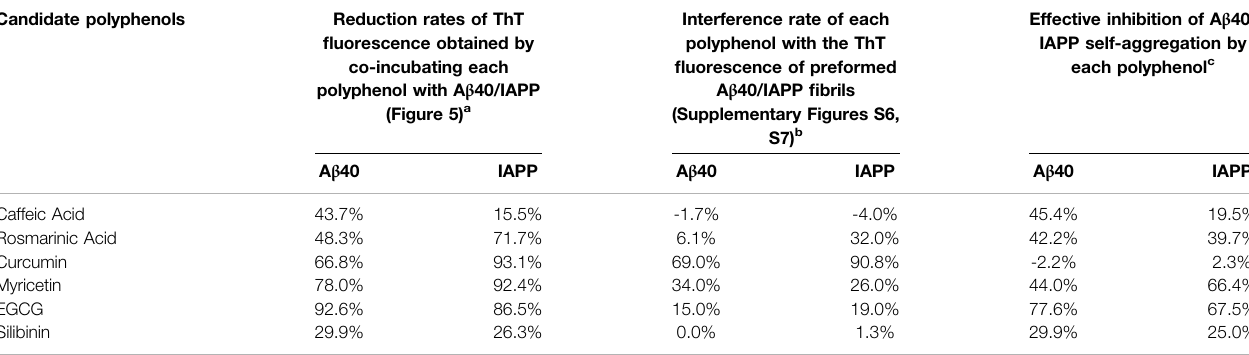
a Reduction rates of ThT fl uorescencewere obtained from Figure 5 by calculating the reductions ofthe normalizedThT fl uorescenceof A β 40 or IAPP in the presence of each polyphenol relative to the control (A β 40 alone/IAPP alone) × 100. b InterferenceratesofThT fl uorescencewereobtainedfrom SupplementaryFiguresS6,S7 at λ em 486 nmbycalculatingthereductionsoftheThT fl uorescenceofpreformedA β 40/IAPP fi brils in the presence of each polyphenol relative to the control (preformed A β 40/IAPP fi brils) ×